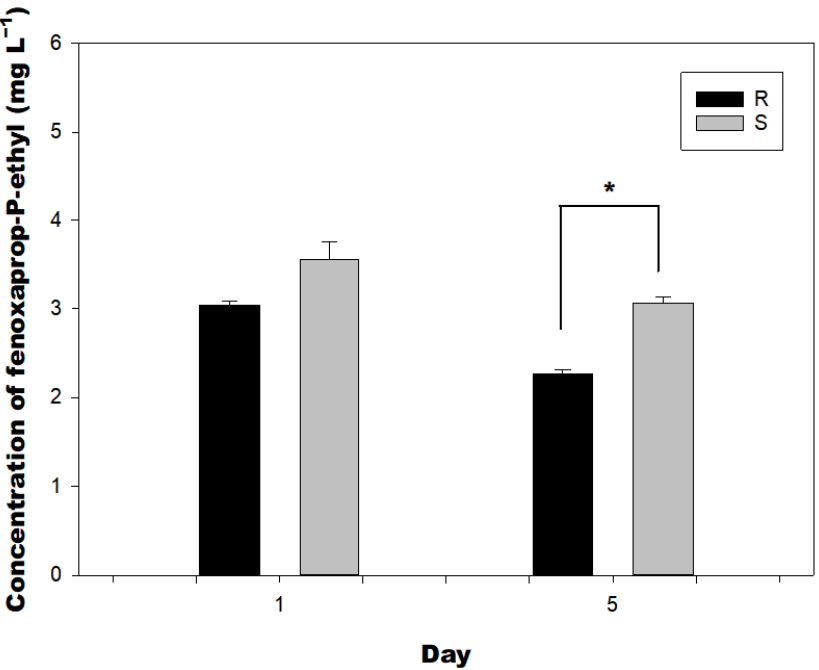
Figure 4. Concentration to fenoxaprop-P-ethyl of resistant (R) and susceptible (S) Alopecurus japoni- cus populations. Data are means ± SE ( n = 3). Asterisk indicates significant differences by T-test ( p < 0.05).